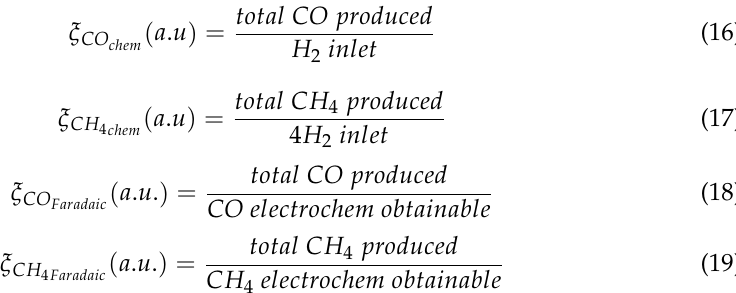
Table 2. Most relevant chromatographic data achieved with bare and coated cells.